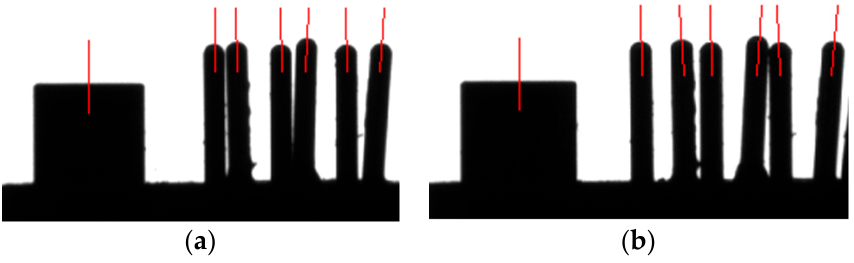
Figure 9. The image of the peg and pins was captured by the camera in the view direction: ( a ) 𝜃 (cid:3029)(cid:2869) (cid:3404) 7° , and ( b ) 𝜃 (cid:3404) (cid:3398)7° . The red lines, which will be used to calculate the deviations, represent the (cid:3029)(cid:2870) centers of the peg and pins. generate the error bars for the data in Table 2. As shown in Figure 10, some results overlap, and the others are close enough. Subtracting the data in the “bottom” row from the data in Table 2. The deviations of the first six pins of the three samples measured in case study two. “Side” the “side” row for the three samples in Table 2 gives differences ranging from − 0.029 to means that the measurement was performed from the side of the samples using the proposed +0.022 mm. method, and “bottom” means that the measurement was performed from the bottom of the samples using the 2D VMM.